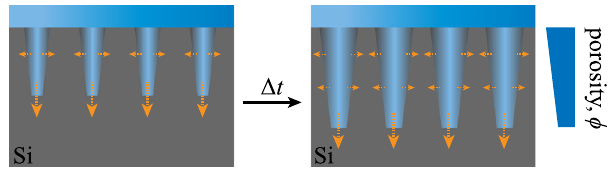
Fig. 2 Pore widening in nanoporous silicon. Isotropic pore widening during electrochemically etching silicon, which causes the depth-dependent